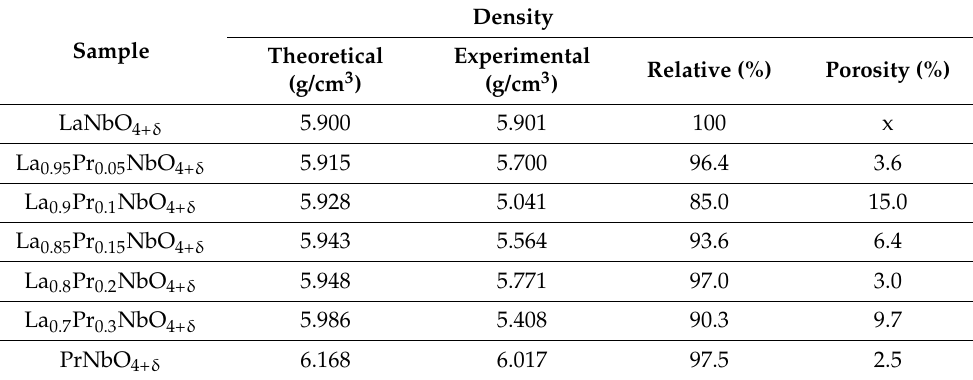
Table 2. Densities of sintered pellets determined with the Archimedes method. The theoretical densities are calculated with the use of the LeBail refinement results (Table